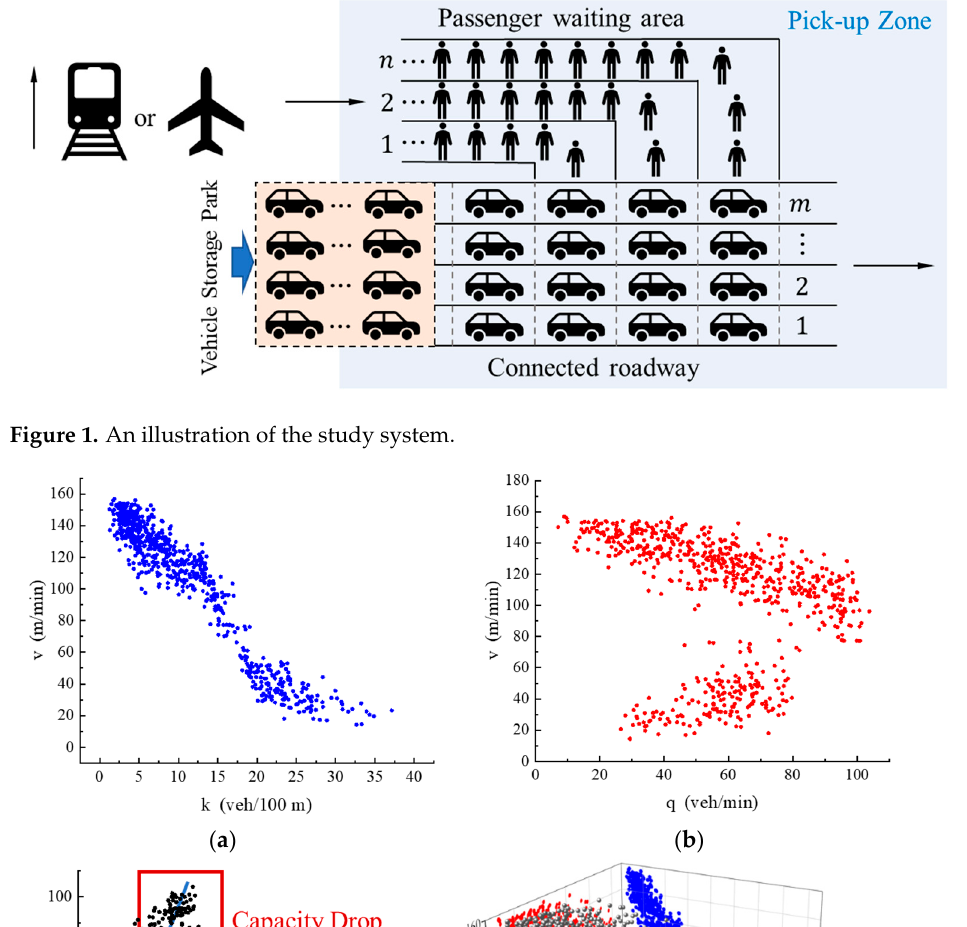
Figure 1. An illustration of the study system.